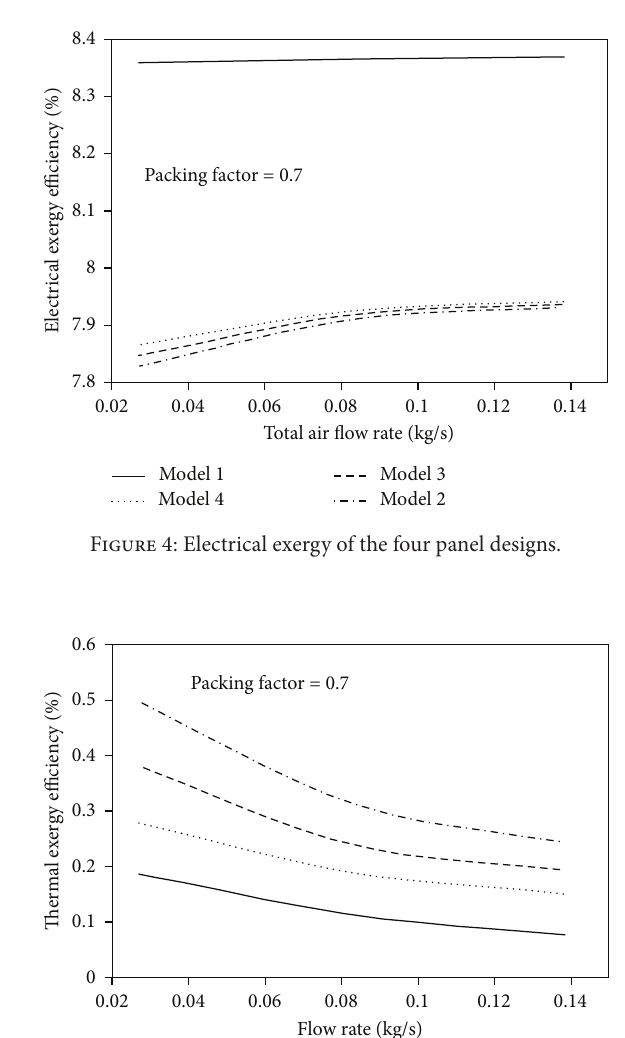
Models 2, 3, and 4 showed lower electrical exergies compared with Model 1 because of the reflection caused by additional glazing. Moreover, the white reflector only had 70% reflection performance, which affected the electrical exergy output of the rear surface of bifacial cells in all four models. Electrical exergy efficiency increases by increasing the air flow rate (Figure 4), which is attributed to higher heat extraction rate, lower PV panel temperature, and higher PV panel electrical efficiency consequently (see (7)). Model 1 is the most simple panel design among four models, which shows the best performance in terms of electrical output exergy.